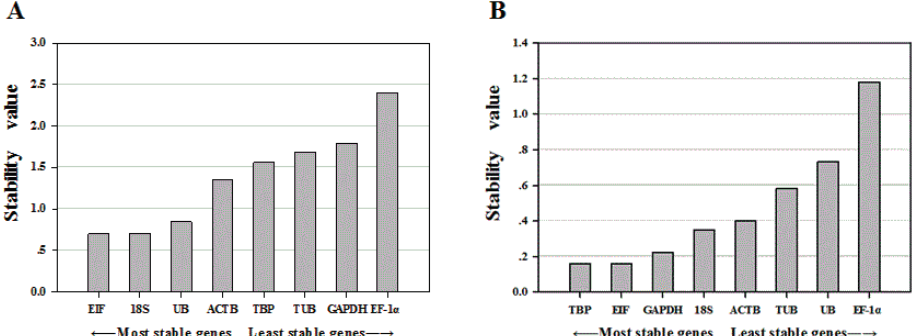
Figure 2. Expression stability of eight candidate reference genes calculated by geNorm. The expression stability value (M; y -axis) is a measure of gene expression stability. ( A ) Expression stability of different tissues in P. clarkii ; ( B ) Expression stability of different ovarian developmental stages in P.